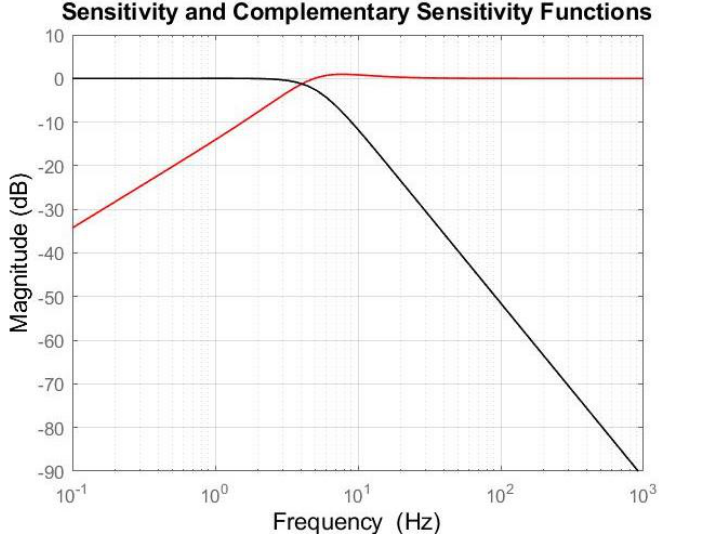
Figure 8. S ( s ) (red line) and T ( s ) (black line).